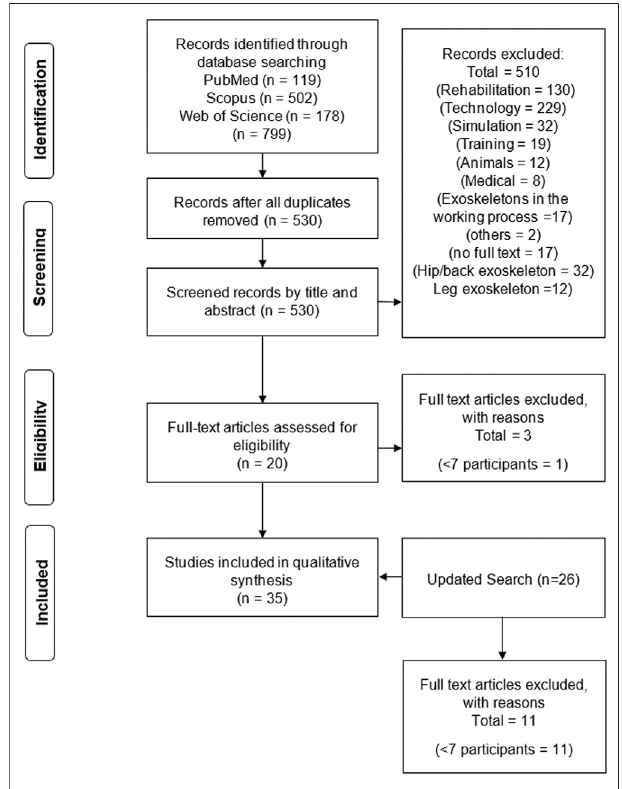
FIGURE 2 | Flowchart of study section process (adapted according to Moher et al.,